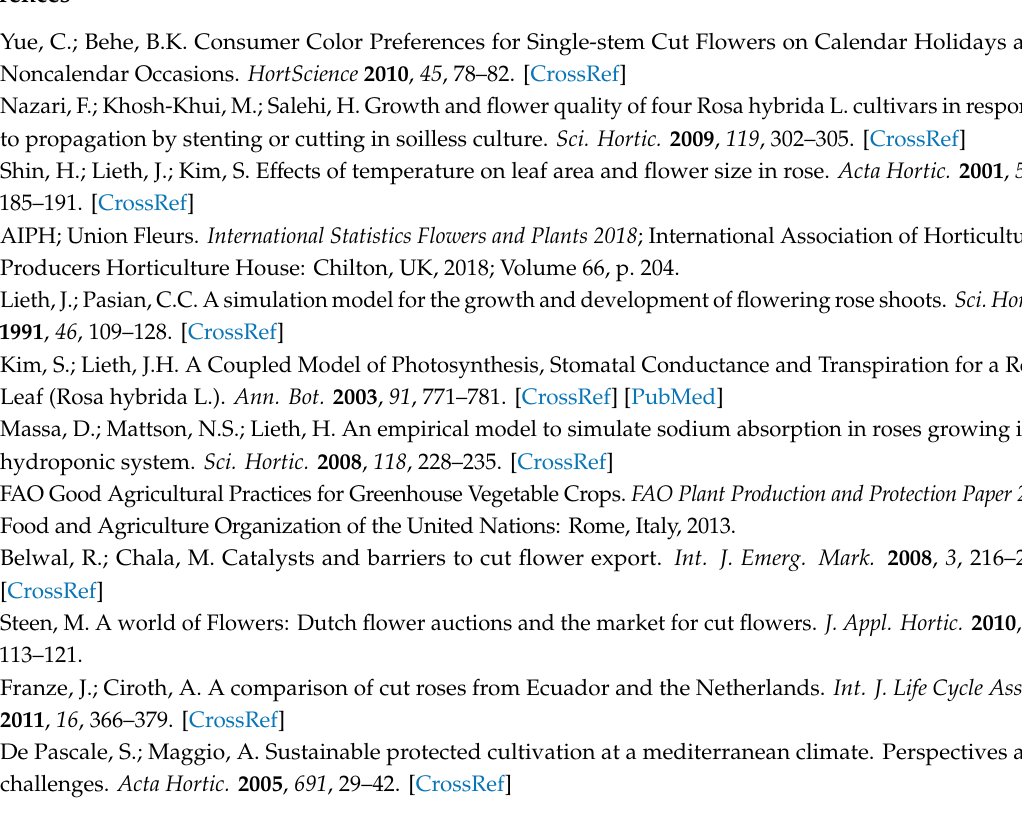
Figure S1: Characteristics of greenhouse located close to Vittoria (South-East of Sicily–Italy − 36 ◦ 55 (cid:48) 19.2” N, 14 ◦ 32 (cid:48) 56.7” E) with a single module of 200 m × 35 m. The height is 6 m at the top and 4.3 m at the eaves. The greenhouses were covered with an 18-month polyethylene film with a thickness of 0.1 mm, Figure S2: Map with the geographic location of the analyzed sites (red